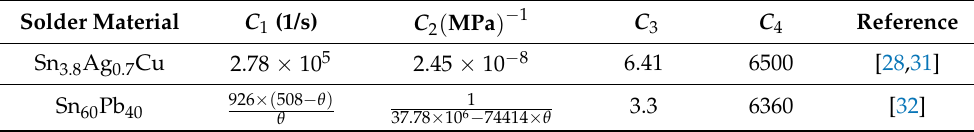
Table 2. Creep parameters for Garofalo-Arrhenius model.